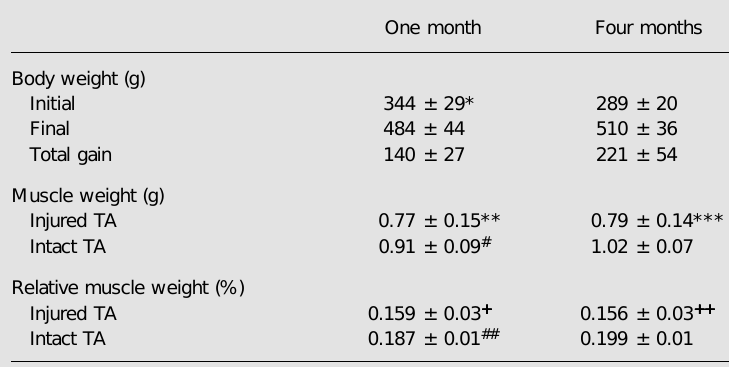
Table 1. Body and tibialis anterior (TA) muscle weight of the one- and four-month groups of